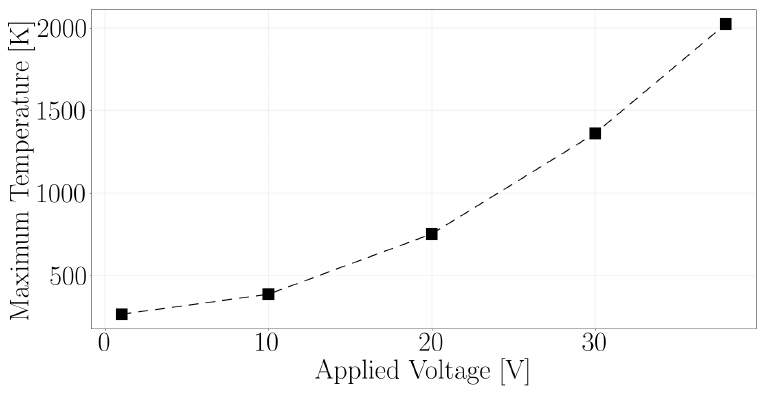
Figure 13. Electrical heating sensitivity analysis: struts domain maximum temperature